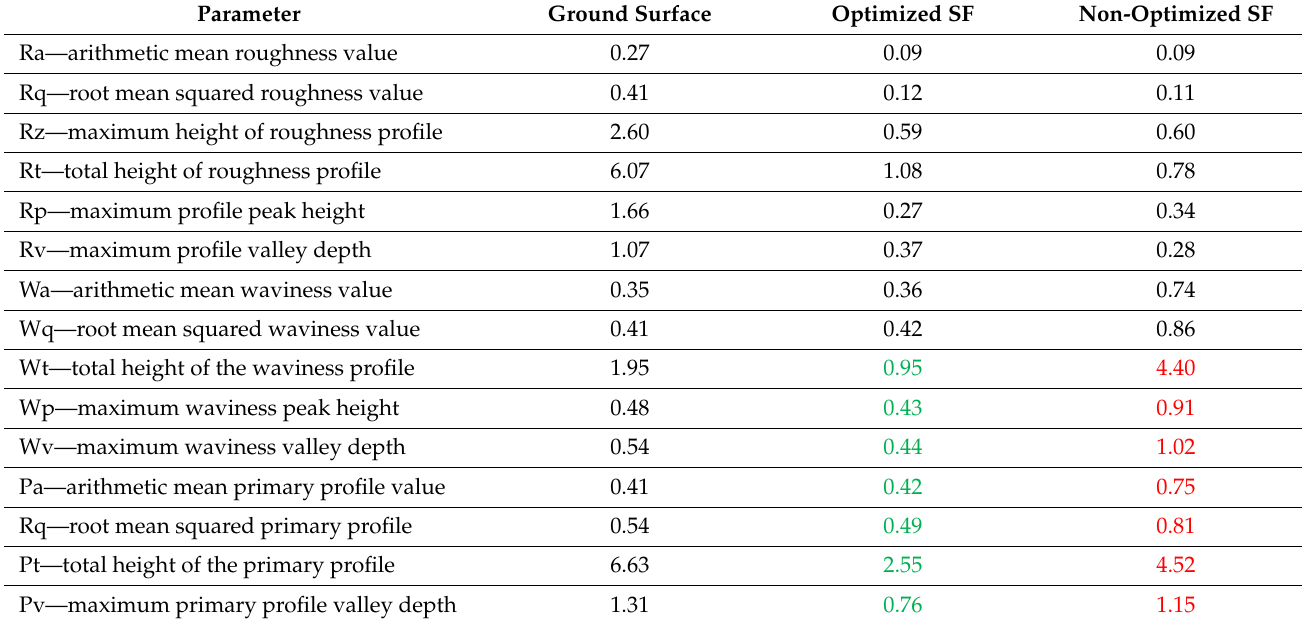
Table 1. Surface texture parameters after Stream Finishing vs ground surface. Values are in µ m.